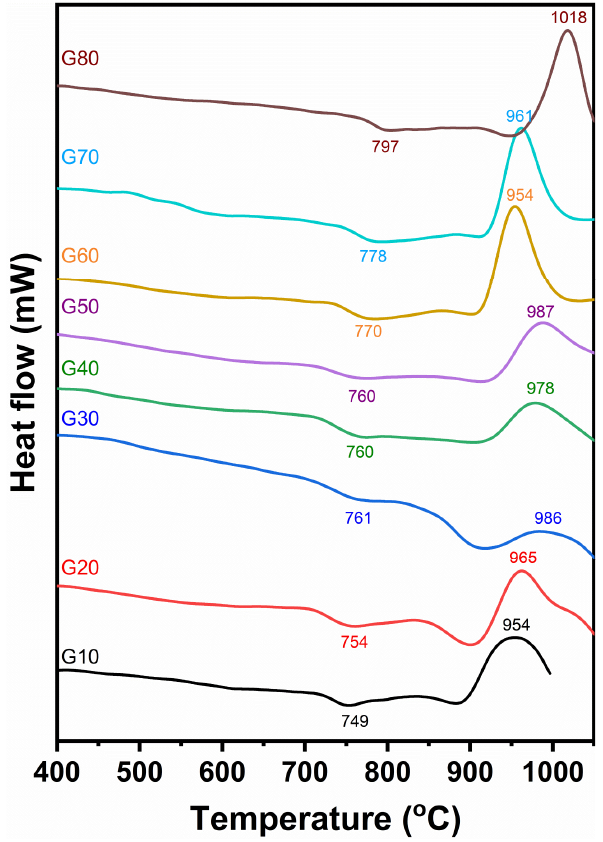
Figure 2. Differential thermal analysis of the investigated glasses.